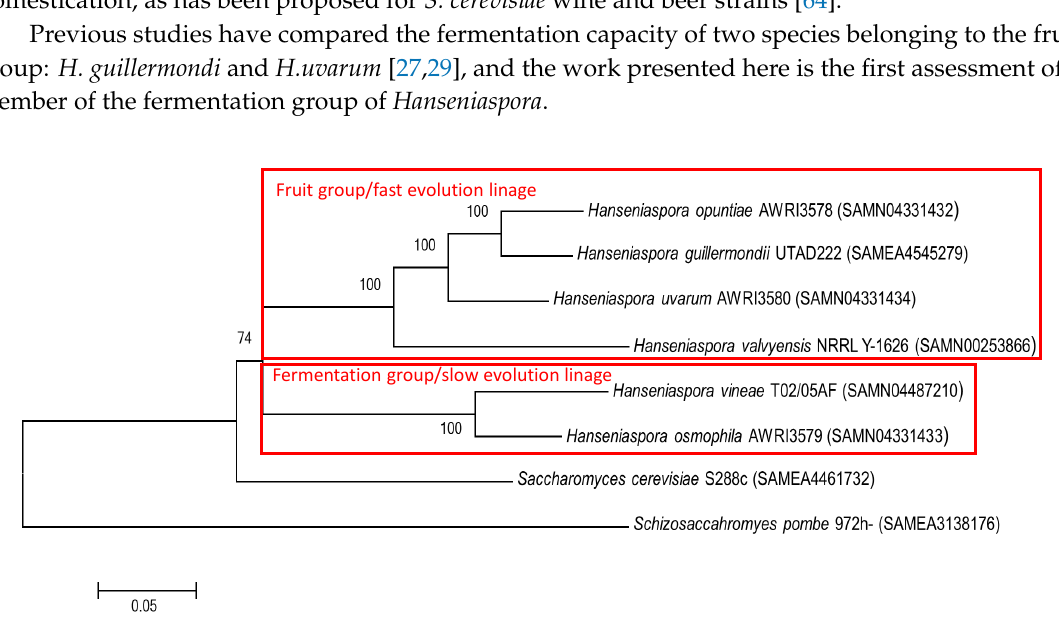
Figure 6. Dendrogram of seven concatenated DNA sequences from Hanseniaspora species constructed using the neighbour-joining method. The robustness of branching is indicated by bootstrap values (%) calculated for 1000 subsets. The entries in brackets correspond to NCBI BioSample identifiers.